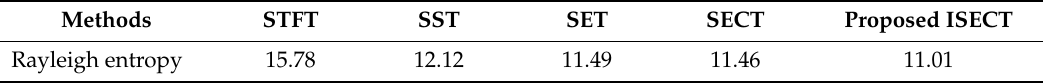
Table 1. Rayleigh entropy calculated by di ff erent methods.